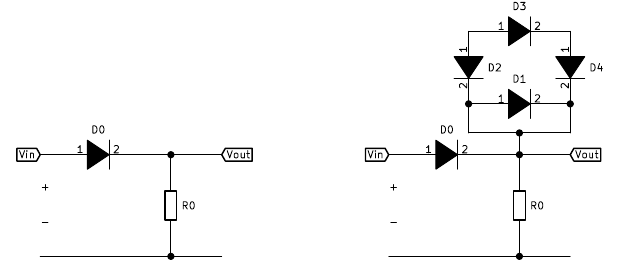
Figure 3. Rectifier false-robustness